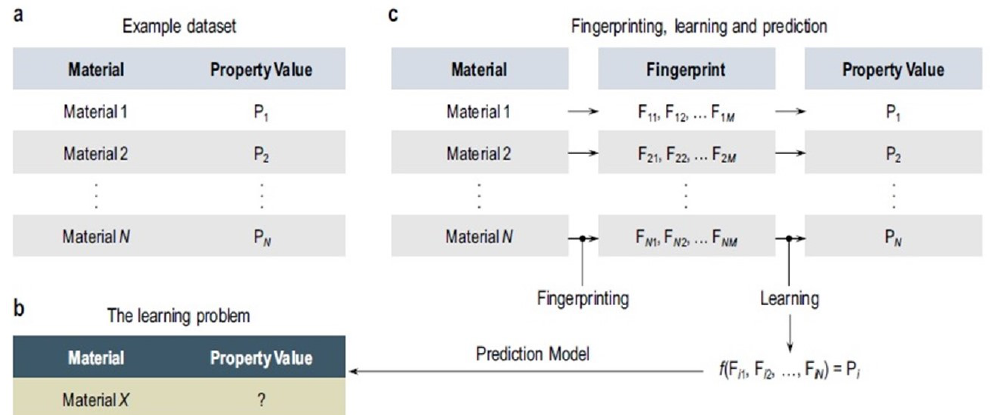
Figure 8. Key elements of machine learning in materials science. ( a ) Schematic view of an example dataset, ( b ) statement of the learning problem, and ( c ) creation of a surrogate prediction model, via the fingerprinting and learning steps. N and M are, respectively, the number of training examples and the number of fingerprint (or descriptor or feature) components. Reprinted with permission from [162]. Copyright 2017, for Springer Nature.